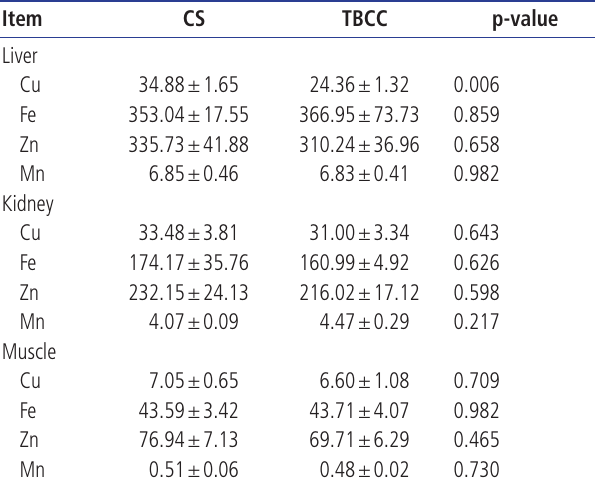
Table 4. Effects of copper sulfate (CS) and tribasic copper chloride (TBCC) on the concentration of Cu, Fe, Zn, and Mn in tissues on d 81 (mg/kg dry matter)